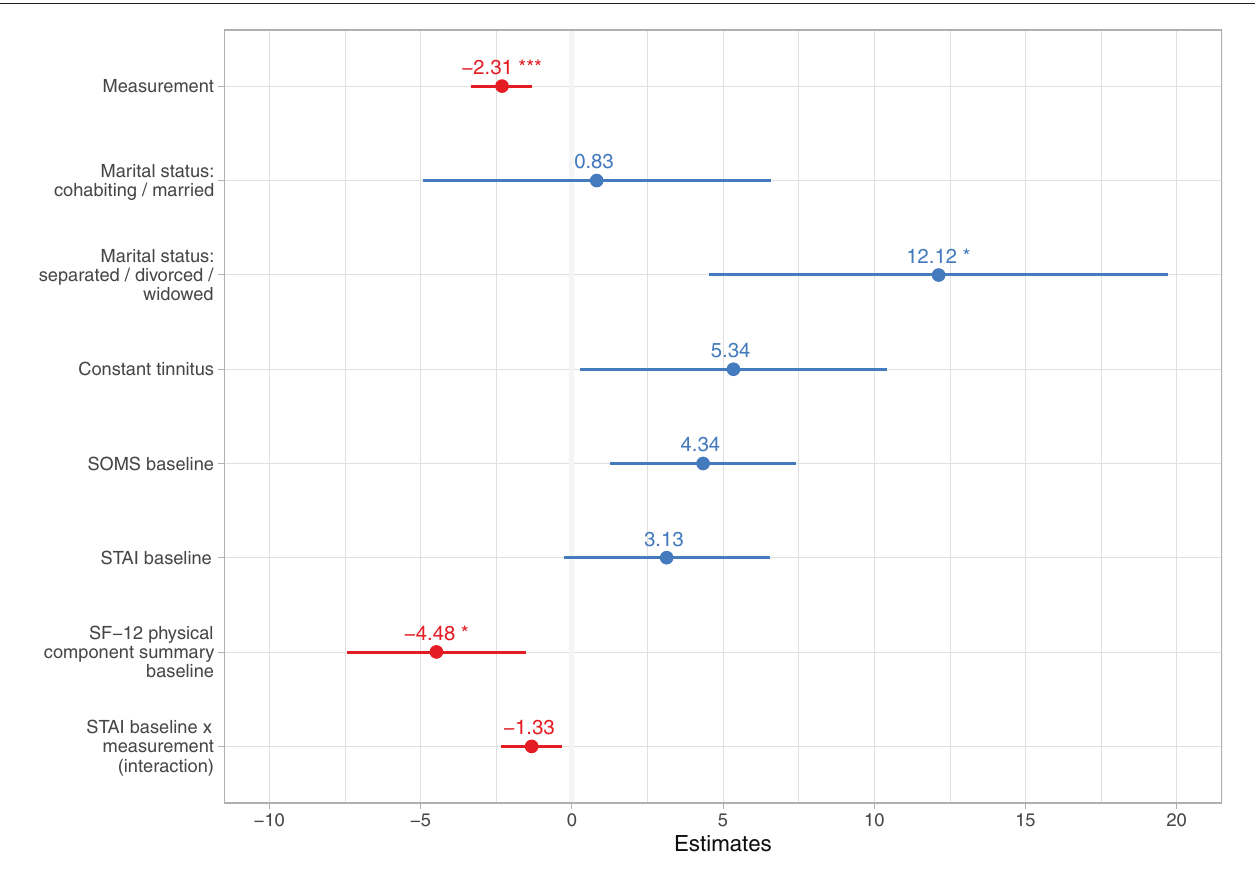
FIGURE 2 | Reduced linear mixed-effects model with stepwise backward elimination for change in Tinnitus Questionnaire (TQ) scores across baseline, treatment end, and follow-up ( N = 80). Numbers indicate estimated coefficient effects and lines depict 95% confidence intervals. Significance levels are displayed after adjustment for multiple testing with Holm’s method. SF-12, Short Form-12 Health Survey; SOMS, Screening of Somatoform Disorders; STAI, State-Trait Anxiety Inventory (State Anxiety). * p < 0.05; *** p <